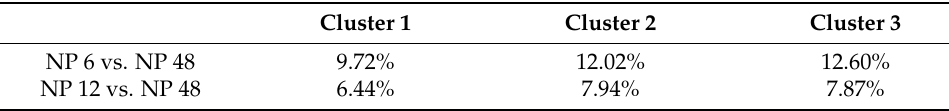
Table 5. AAPE of the estimated production results by